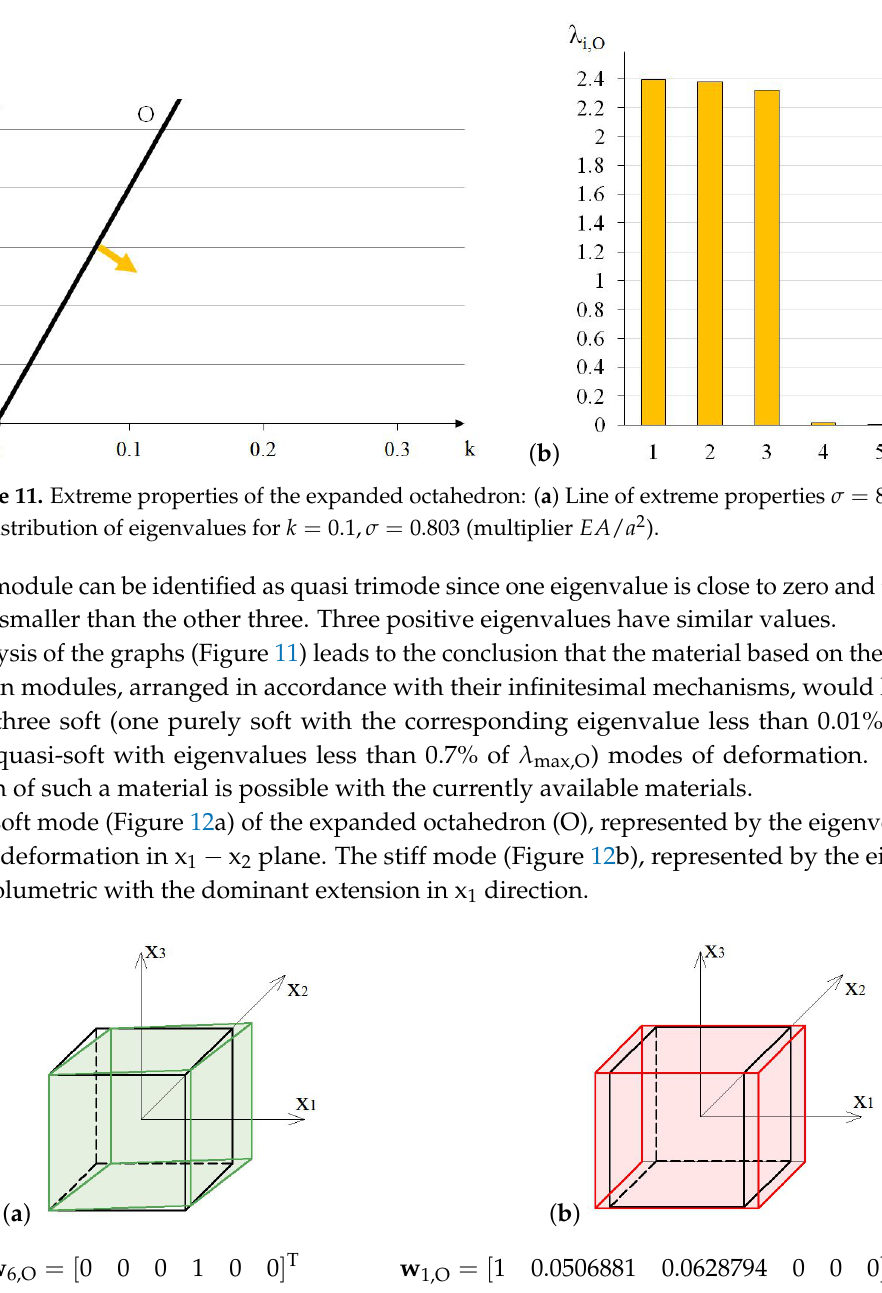
Figure 12. Deformation modes of the expanded octahedron: ( a ) Soft mode. ( b ) Stiff